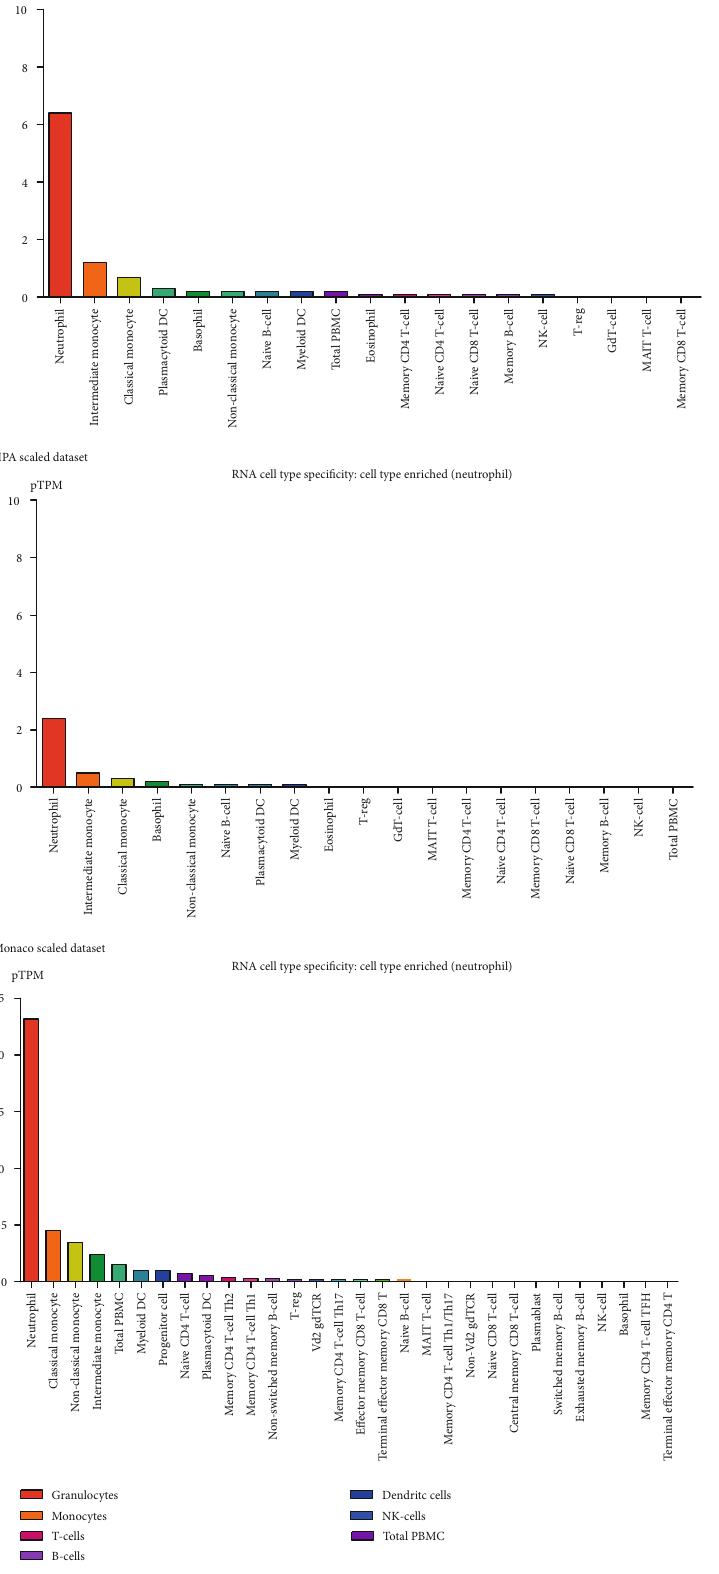
RNA cell type specificity: cell type enriched (neutrophil)